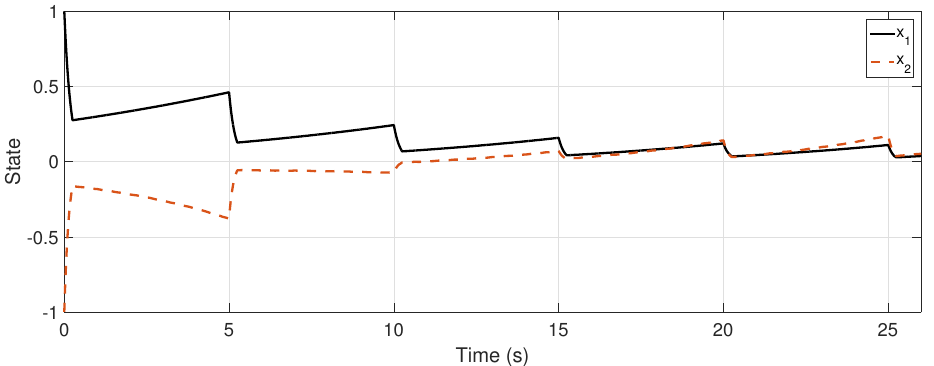
Figure 6. System trajectories, under arbitrary changes in parameters/entries of the system’s matrix with the switching law designed in